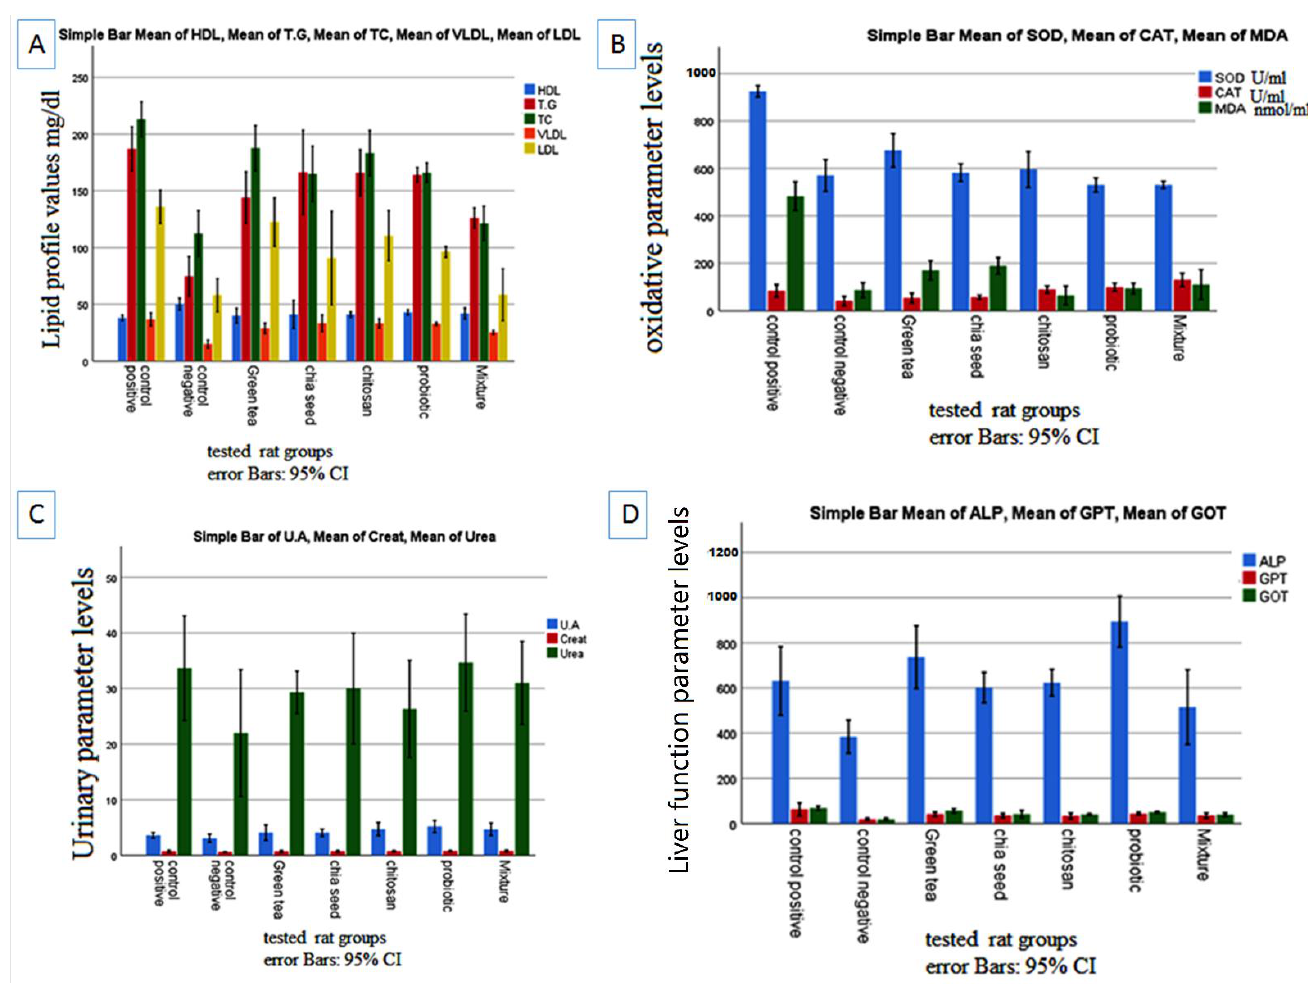
Figure 2. Effect of prebiotics and probiotics on rats fed with high-fat diet. ( A ) Lipid profile parameters; ( B ) oxidative parameter levels; ( C ) urinary parameter; ( D ) liver function.